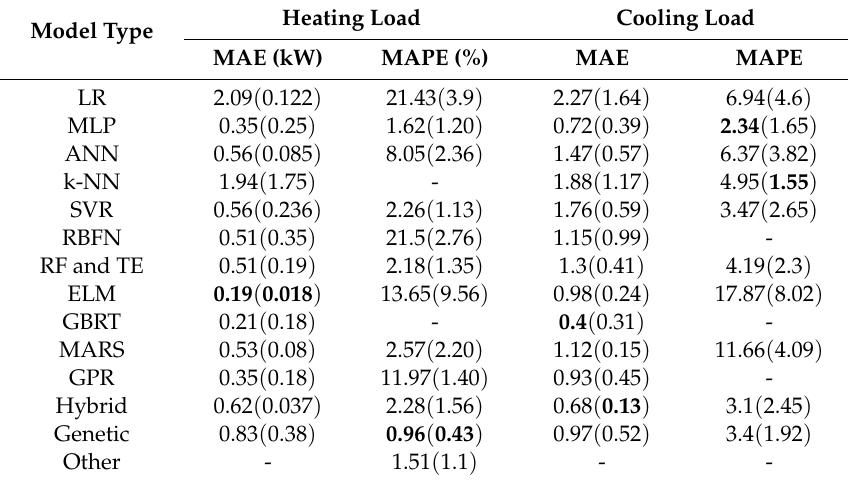
Table 4. Median and minimum MAE and MAPE for di ff erent Machine Learning techniques. Bold value represent the smallest value of each model’s quality